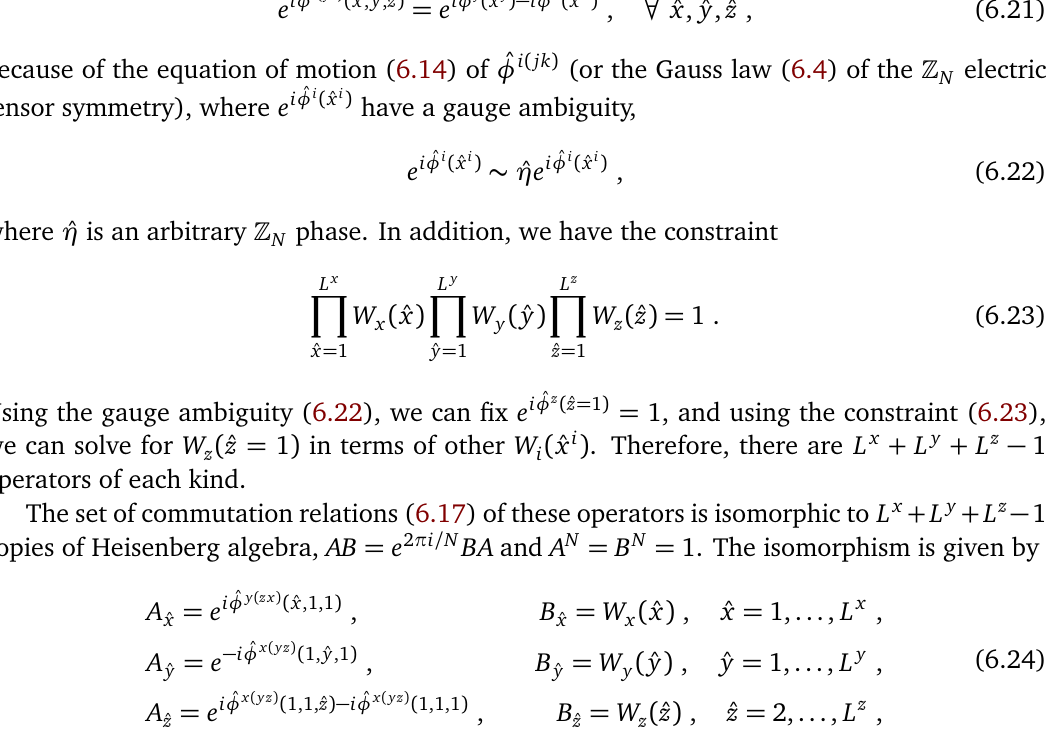
Figure 2: The global symmetries of the U ( 1 ) A -theory, the U ( 1 ) C -theory, the (cid:90) C -theory, and their relations. The electric tensor symmetry of the A -theory is gauged and therefore it is absent in the (cid:90) gauge theory. Note that the U ( 1 ) C -theory does N not have a magnetic